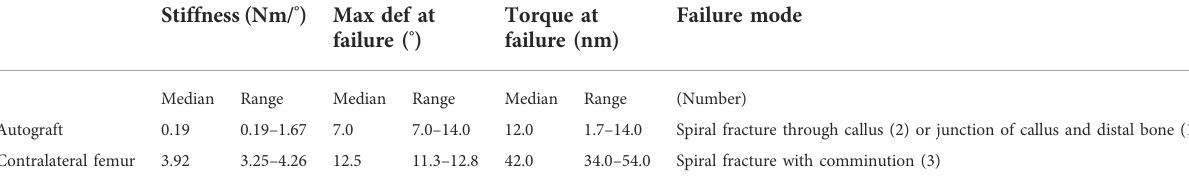
Table 1: At 18 weeks, three pair of femur from the autograft treatment group ( n = 6 femur) were assessed for biomechanical properties in torsion. Autograft = Right femur, 4 cm defect, stabilizedwithAS-ILN,corticocancellousautograft.Contralateralfemur=leftfemur,non-operatedlimb.Abbreviations:Nm/ ° =Nmperdegree;MaxDefatFailure( ° )=Maximumangleof deformation at failure in